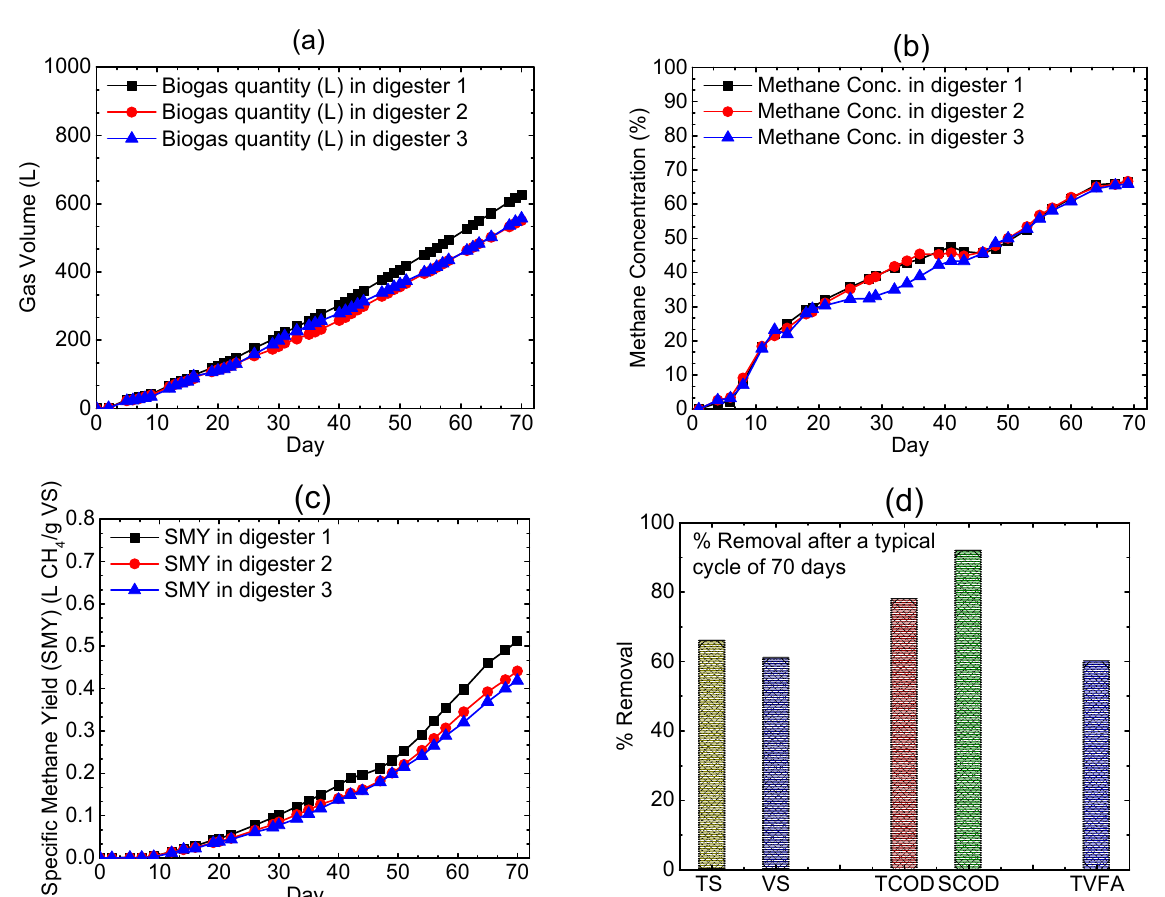
Figure 2. ( a ) Cumulative biogas quantity (L); ( b ) CH 4 concentration profile; ( c ) specific methane yield (SMY); ( d ) percentage removal of TS, VS, TCOD and SCOD for a typical cycle length of 70 days.